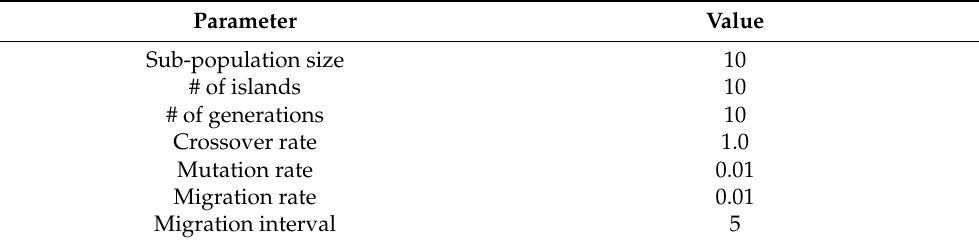
Table 6. Parameters used in multi-island genetic algorithm